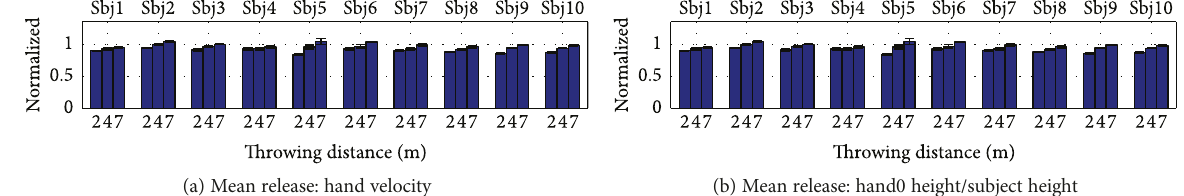
Figure 5: Task space features per subject and throwing distance. Both hand release velocity and release height increased with the throwing distance for all the subjects.